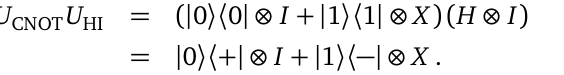
Figure 10: Bell-state generating circuit.